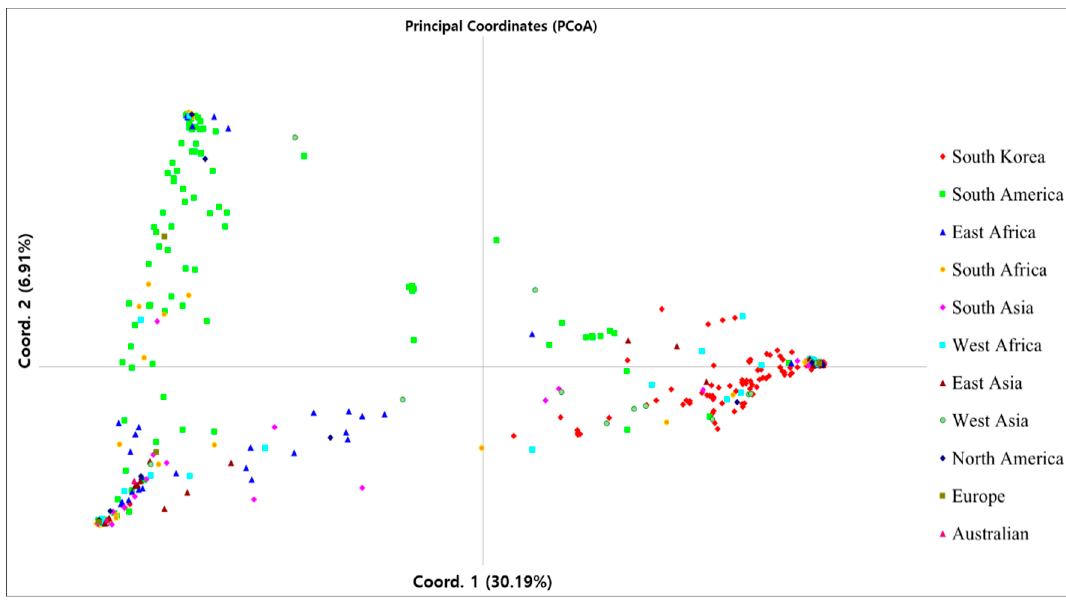
Figure 3. The pattern of Principal Coordinates Analysis